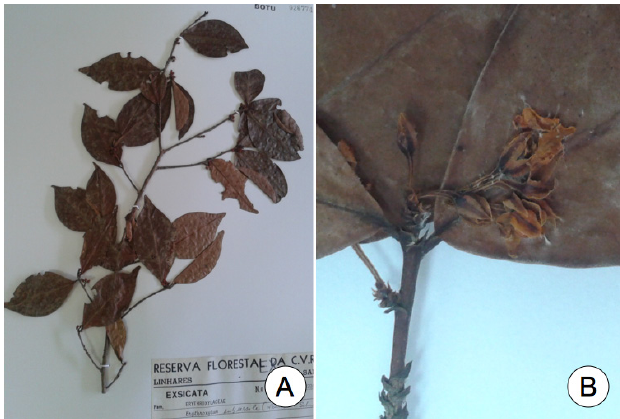
Figure 1. Erythroxylum subsessile (Mart.) O.E. Schulz. A. Main view of sample deposited in Herbarium BOTU (BOTU 026774). B. Detail showing sub-sessile leaves with short and thick petioles and stipule widely triangular and with the same size as the